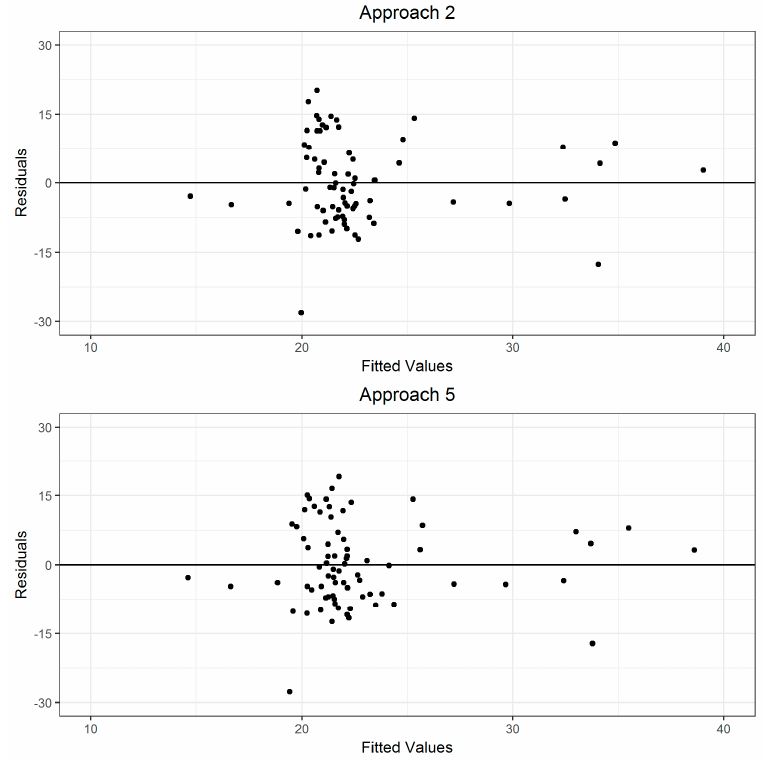
Figure 3. Plots of fitted values vs. residuals obtained in modeling change in biomass (Mg ha − 1 ) using change in lidar metrics using fixed (Approach 2) and mixed (Approach 5) effects models.